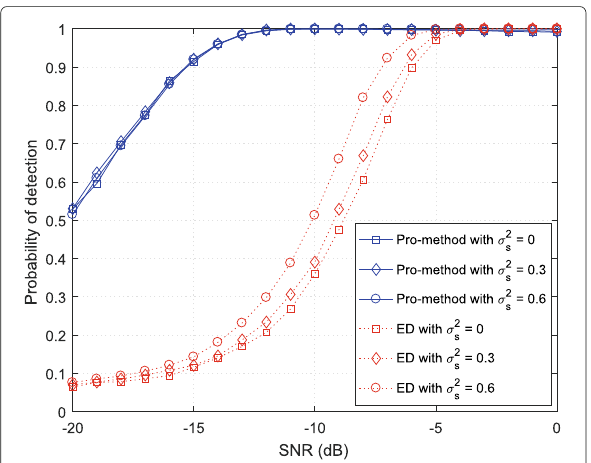
Fig. 9 Probability of detection versus SNR for the proposed method and ED with different σ 2